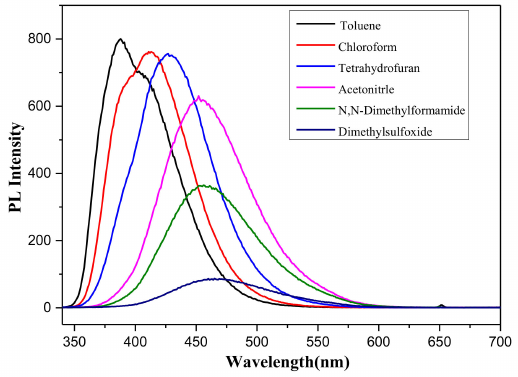
Figure 1. PL emission spectra of 1a in different solutions at the same concentration (10 − 5 mol/L − 1 , excitation wavelength: 322 nm).